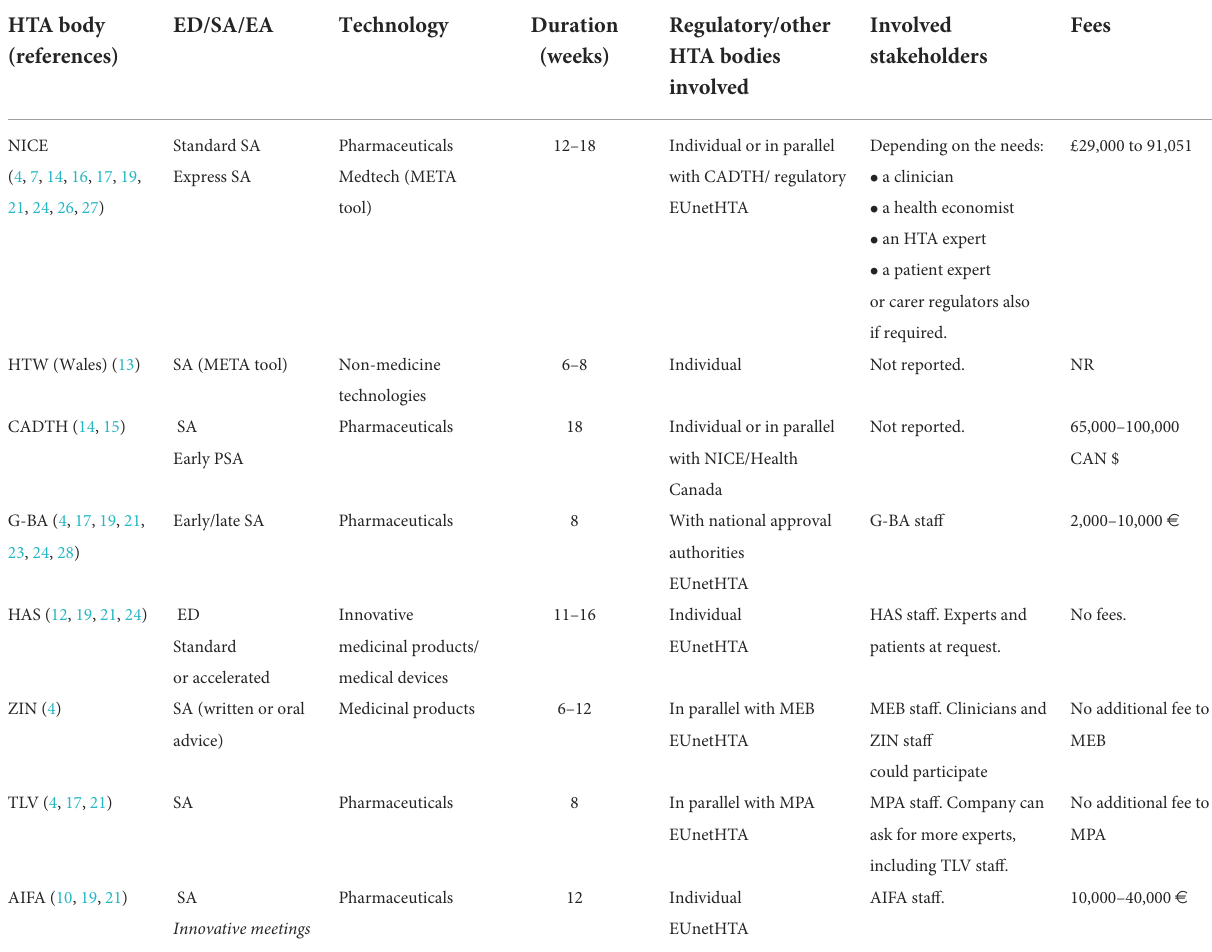
TABLE 1 Scientific advice/early dialogue services by individual HTA bodies.